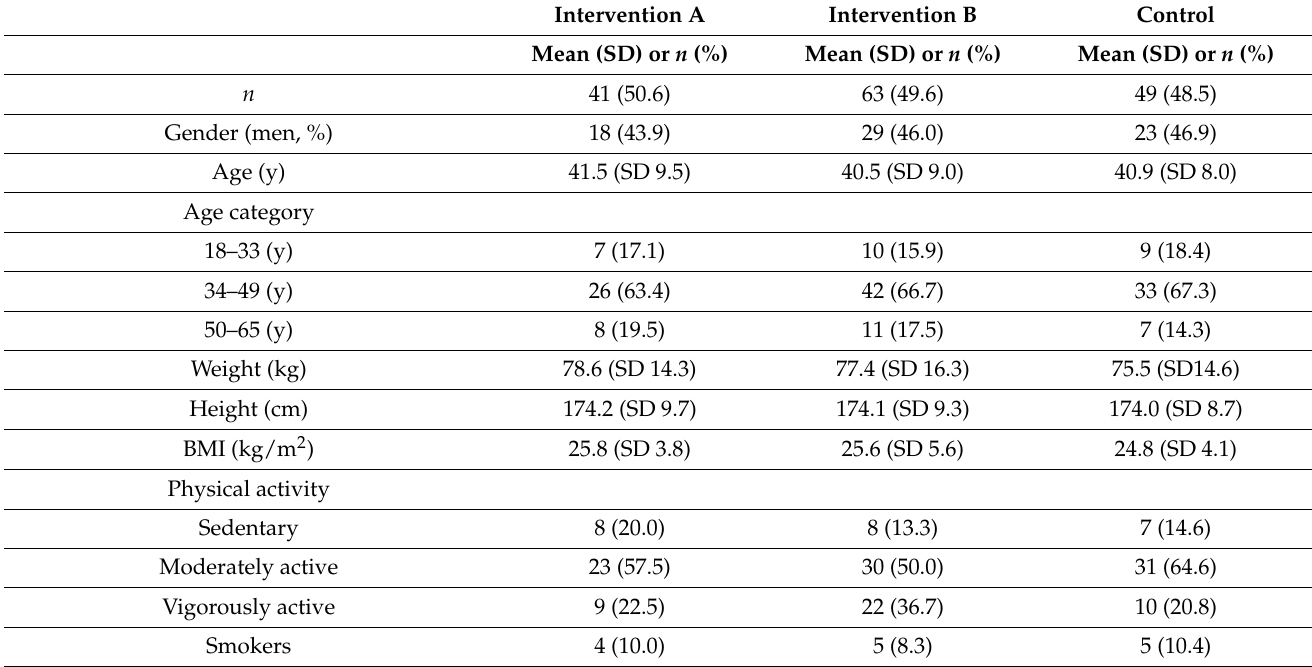
Table 2. Cont. Intervention A Intervention